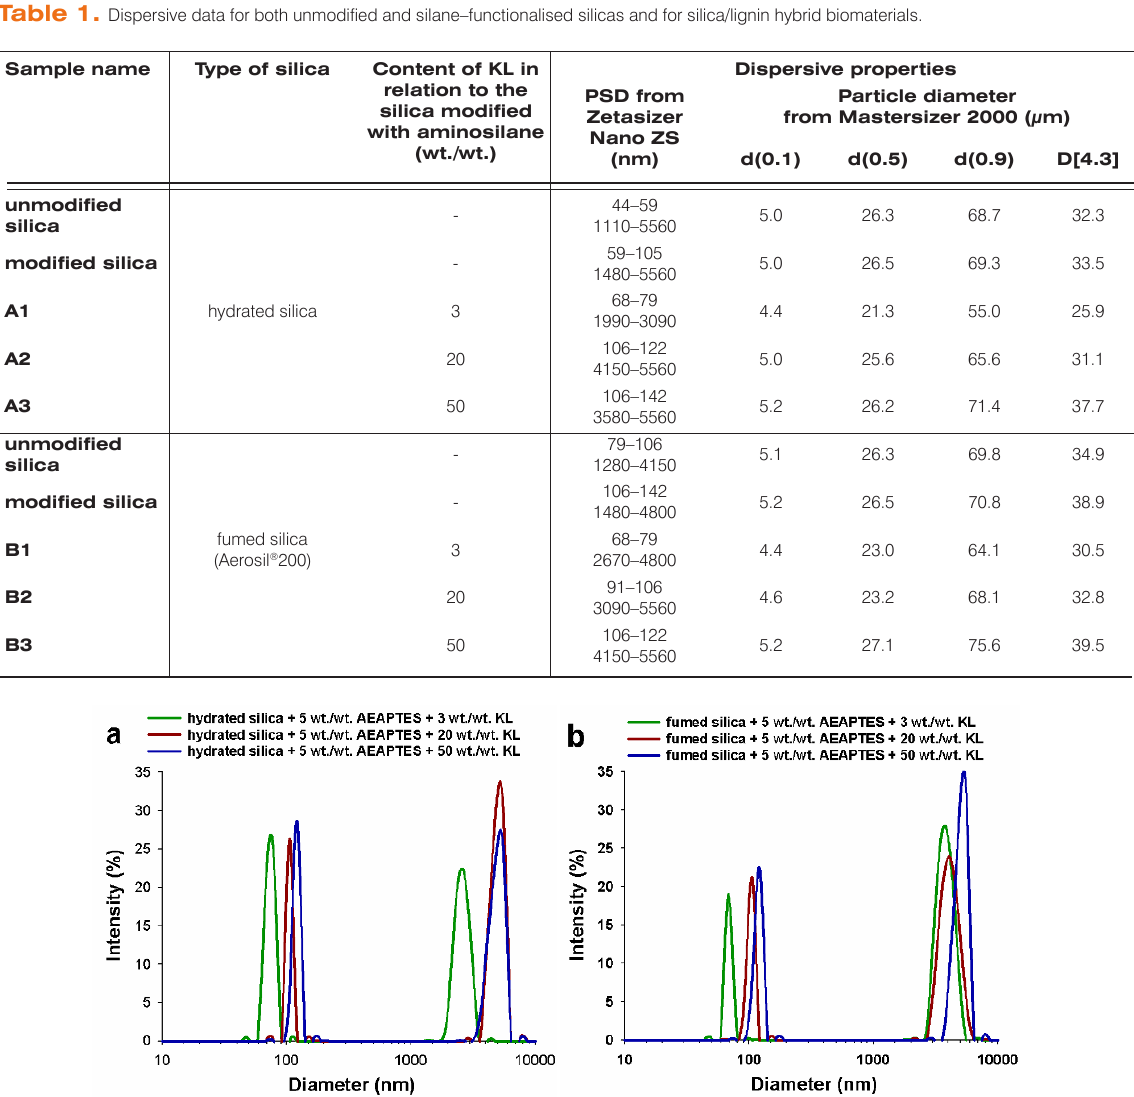
Figure 3. Particle size distributions (Zetasizer Nano ZS) of silica/lignin hybrid materials obtained from hydrated silica (a) and fumed silica (b).